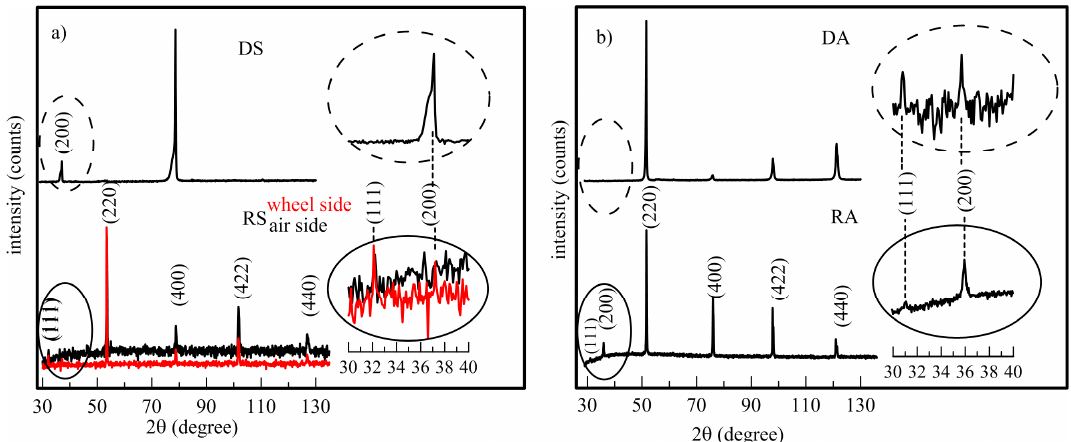
Figure 4. X-ray diffraction patterns for Fe 2 MnSi ( a ) and Fe 2 MnAl ( b ) Heusler alloys prepared by arc melting (DS, DA) and planar flow casting (RS, RA).